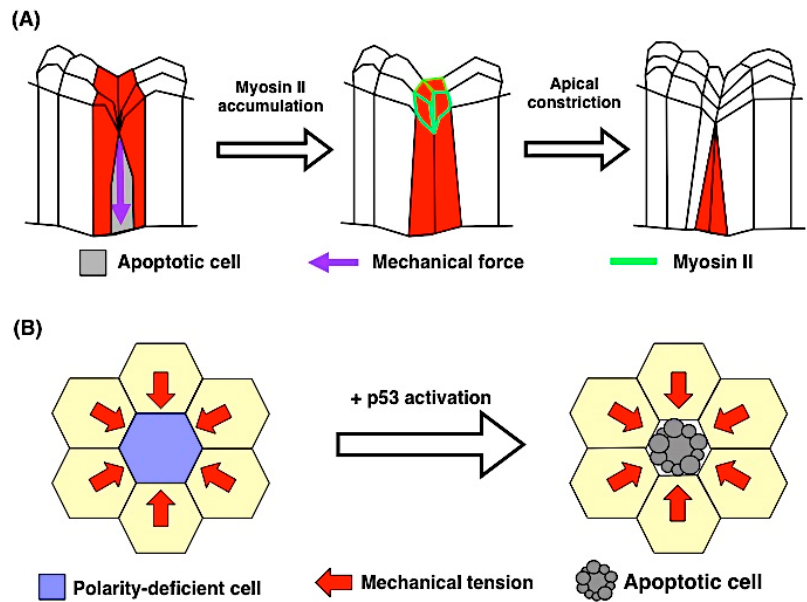
Figure 4. The interaction between apoptosis and mechanical force. ( A ) Apoptosis-induced morphogenetic changes in Drosophila leg joint formation. Apoptotic cells pull their neighbors toward the basal side during delamination at the presumptive joint area. In their neighboring cells, the actomyosin cable accumulates in the apical cortical area. The apical surface of surrounding cells undergoes apical constriction; ( B ) Model for mechanical tension-induced cell competition. In cultured mammalian epithelial cells, compaction by overcrowding induces apoptosis in polarity-deficient cells, which is mediated by the upregulation of p53 . The yellow hexagons represent normal cells.